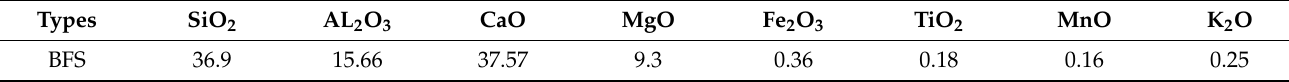
Table 1. Main chemical composition of BFS (%).